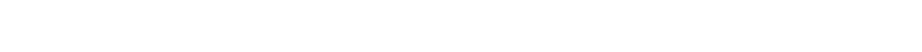
FIGURE 9 |Three-dimensional echocardiography evaluation of the right heart volume and ejection fraction